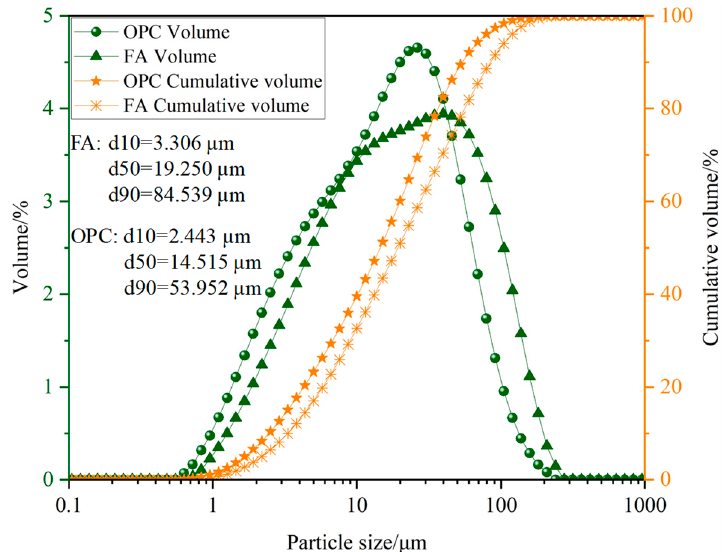
Figure 2. OPC and FA particle size distribution.